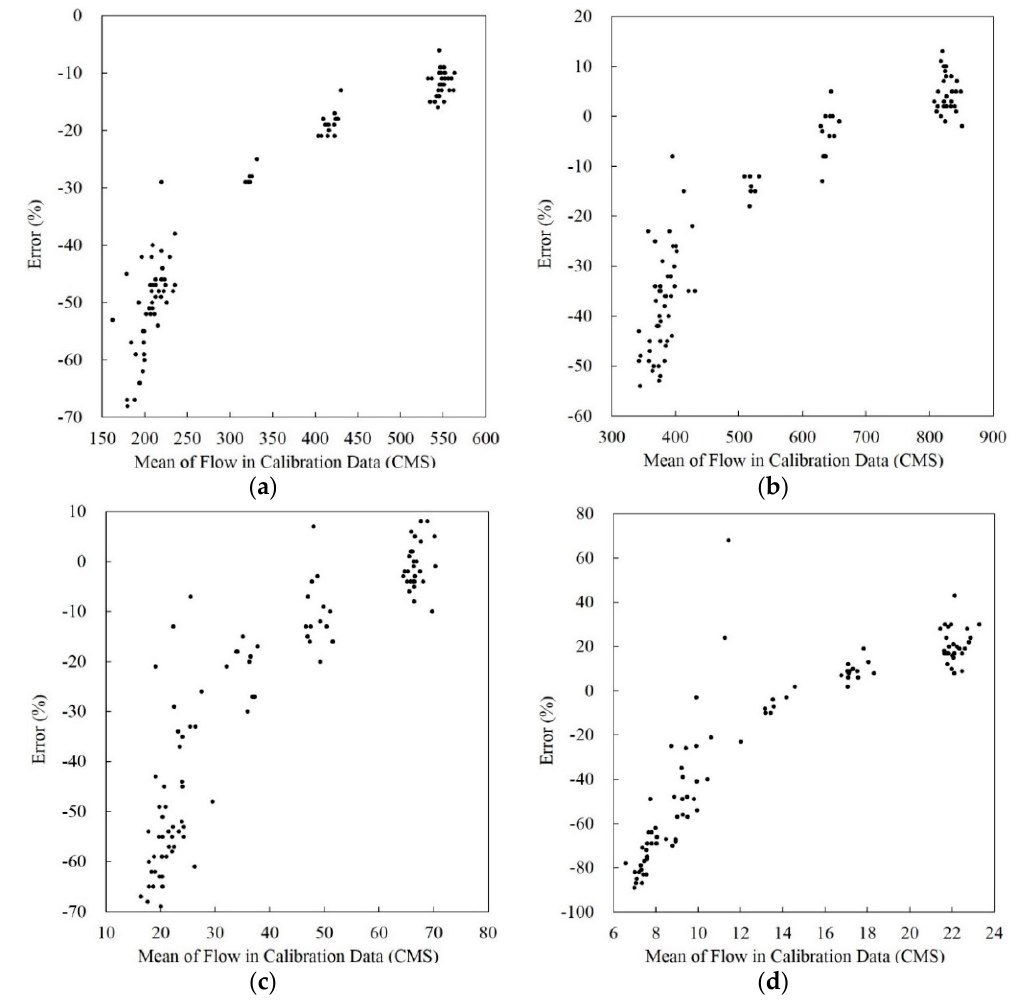
Figure 1. Correlation between errors and mean of flow in calibration data: ( a ) USGS station number 01357500; ( b ) USGS station number 01463500; ( c ) USGS station number 01470500; ( d ) USGS station number 01481000.